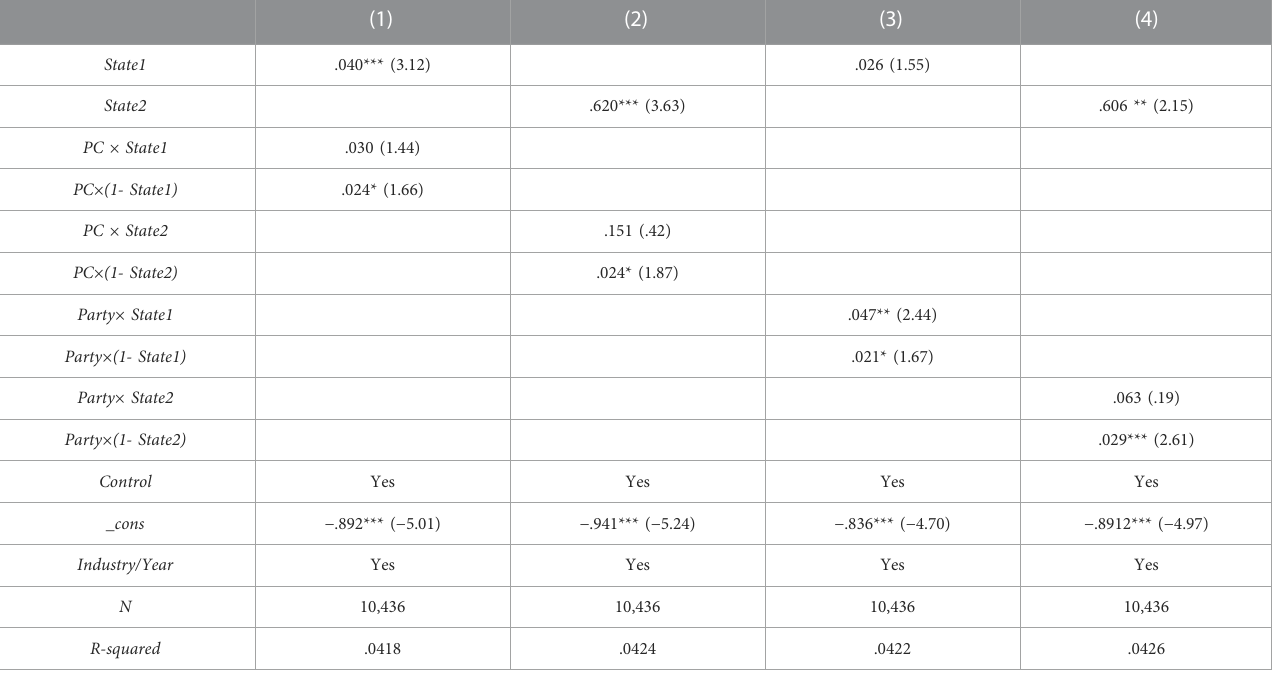
TABLE 9 Test for the substitution effect of state-owned participation shareholders, executive team ’ s participation in politics, and Party organization